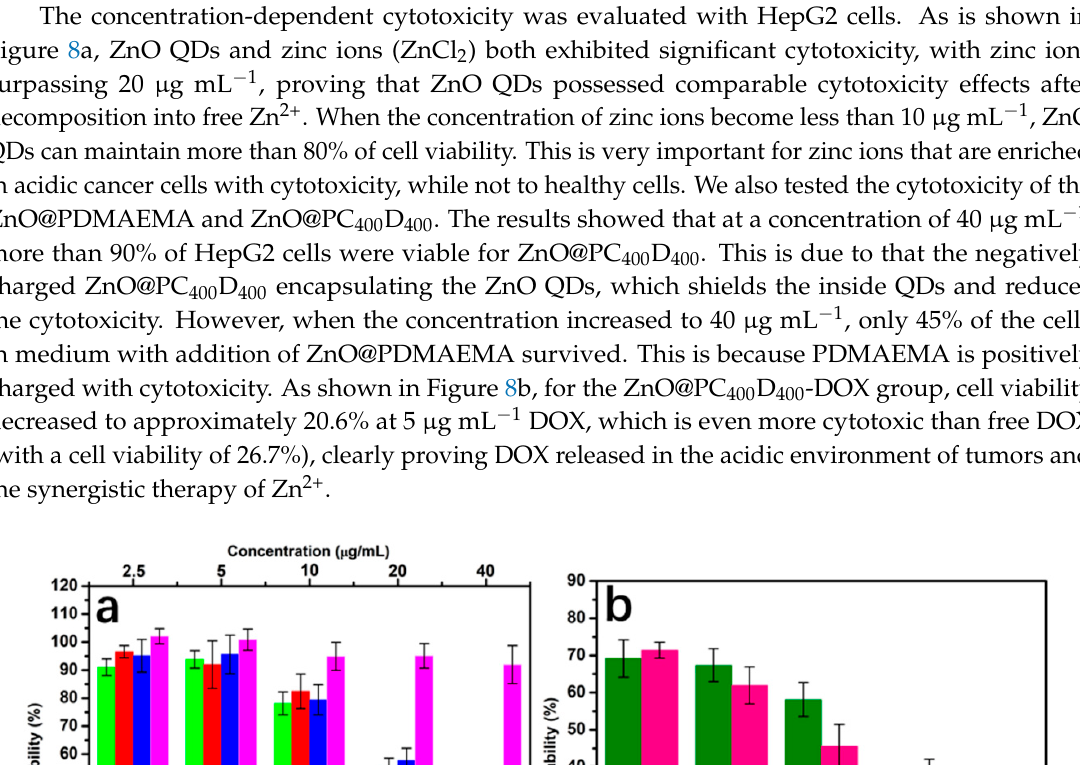
s1, Figure S1: Thermogravimetric Analysis (TGA) of ZnO@PC 400 D 400 , Figure S2: UV-Vis absorption spectra of ZnO@PC 400 D 400 at different storage time at room